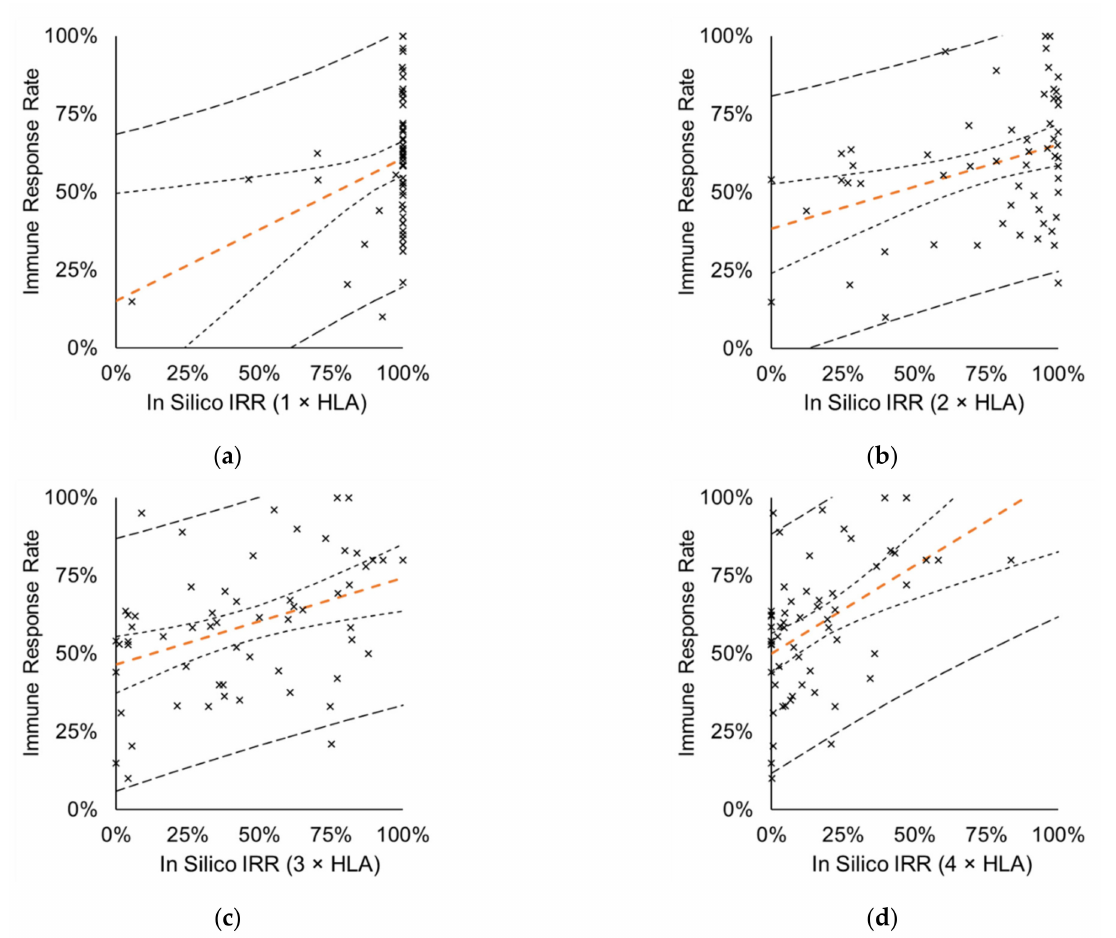
Figure 3. Correlation analysis between in silico and measured IRRs. In silico prediction was based on the proportion of subjects in the MP having at least one vaccine-specific epitope that is ( a ) restricted to ≥ 1 autologous HLA class I allele ( r = 0.3225, p = 0.0127), ( b ) restricted to ≥ 2 autologous HLA class I alleles ( r = 0.3763, p = 0.0033), ( c ) restricted to ≥ 3 autologous HLA class I alleles ( r = 0.4015, p = 0.0016), ( d ) restricted to ≥ 4 autologous HLA class I alleles ( r = 0.4780, p = 0.0001). Analysis included 59 data pairs covering 79 CTs with 55 vaccines. Orange dashed line: perpendicular trend line with 95% confidence interval band (95% prediction interval band is shown by thicker dashed